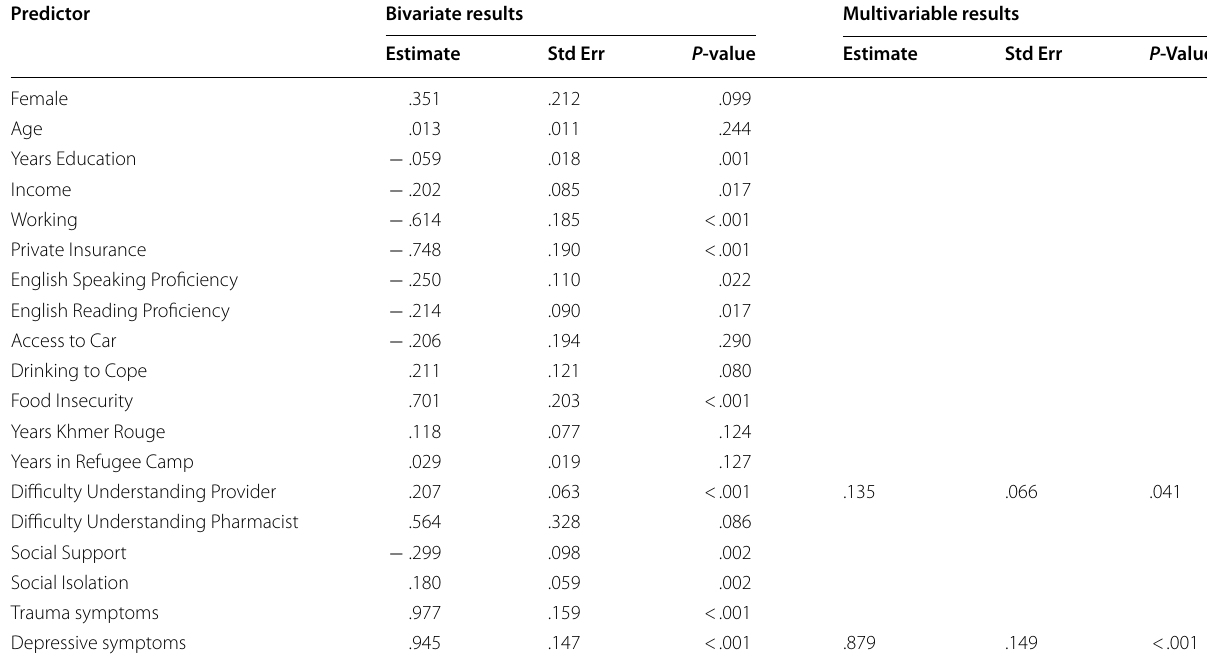
Table 2 Bivariate and Multivariate Results from Negative Binomial Model Predicting Pain Score